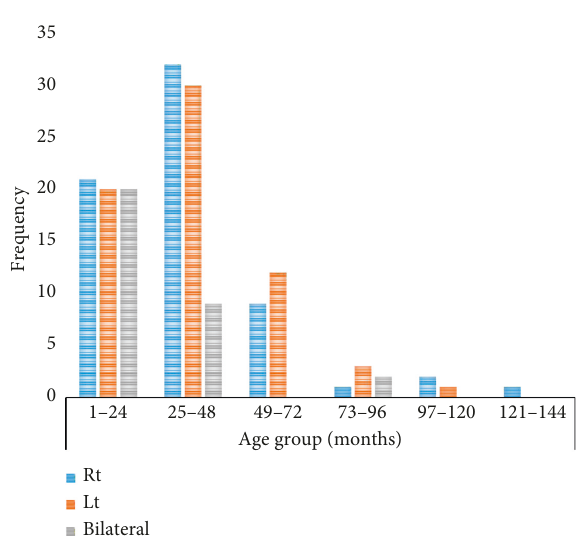
Figure 1: Age at presentation and laterality in retinoblastoma patients.